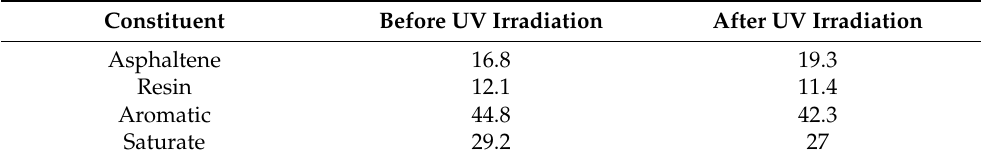
Table 11. SARA analysis result of asphalt mixed with surface treatment